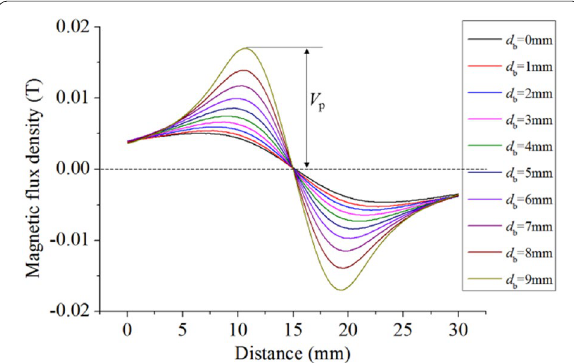
Figure 8 The B zMFL of ten inner defects with same fixed distance d f of 10.0 mm